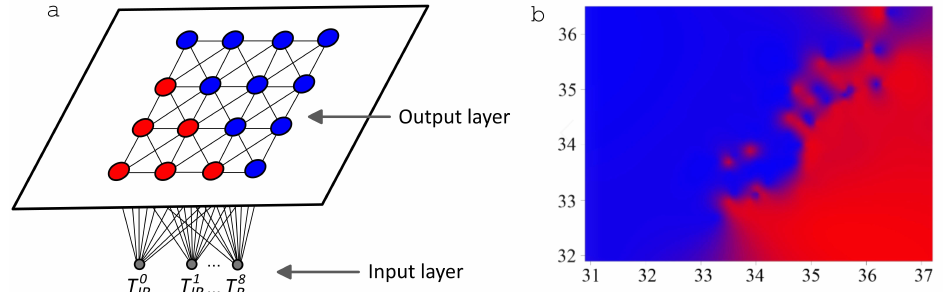
Figure 11. Clustering scheme using Kohonen’s self-organizing map ( a ). An example of the Kohonen map in the projection on the temperature plane: the class of models “Sick” is marked in red, the blue color highlights the class of models “Healthy” ( b ) (the horizontal axis is the temperature ( ◦ C) at the point “0”; the vertical axis is the temperature ( ◦ C) at point “3”).